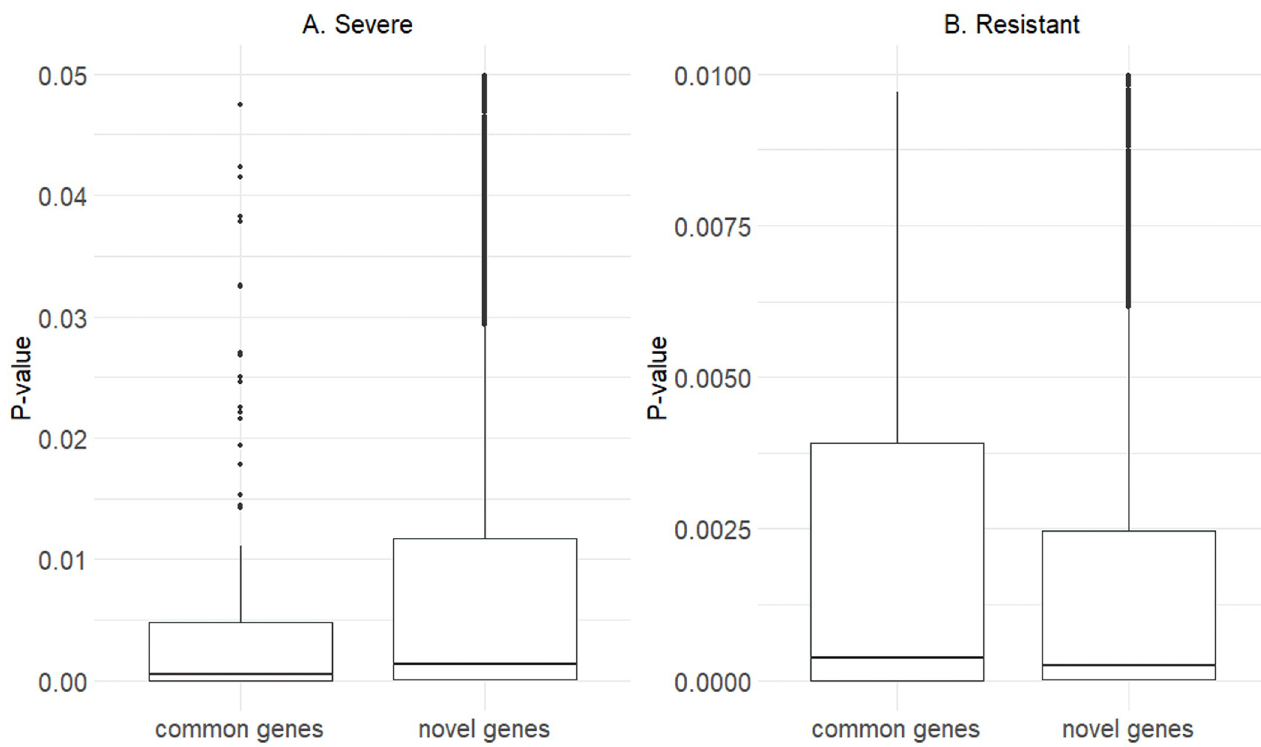
Fig 5. P–values corresponding to groups of SNPs located in genes reported as COVID–19–related in the literature and SNPs located in genes reported as novel by our study.